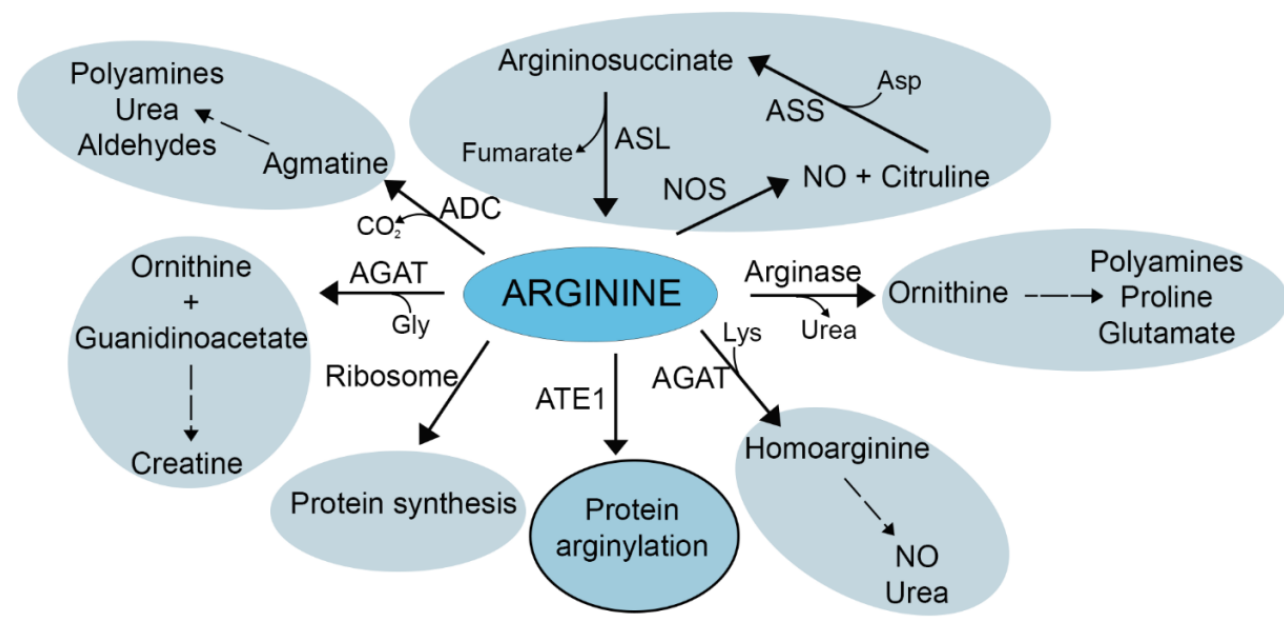
Figure 6. Arginine is a central component in a number of key physiological pathways. Major pathways that critically depend on Arg levels in the cell are shown. Alterations in Arg availability has the potential to critically affect the balance of these pathways, with important consequences to the